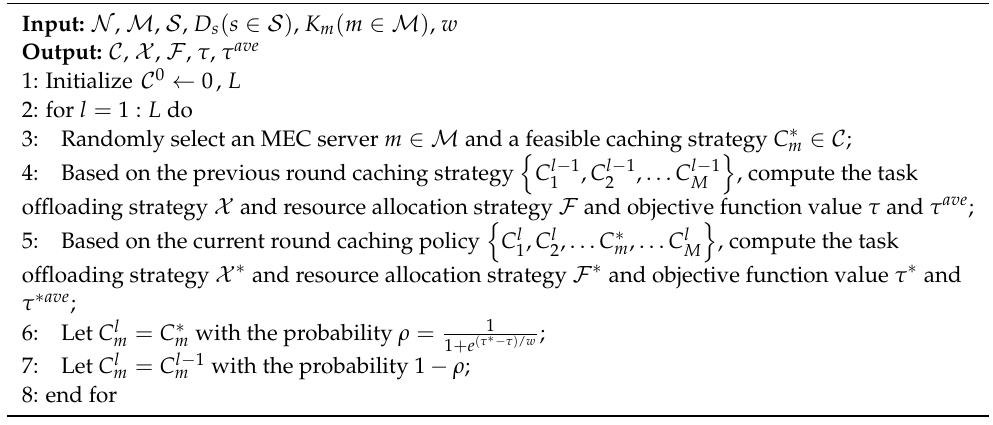
Algorithm 1: Service Caching Algorithm based on Gibbs